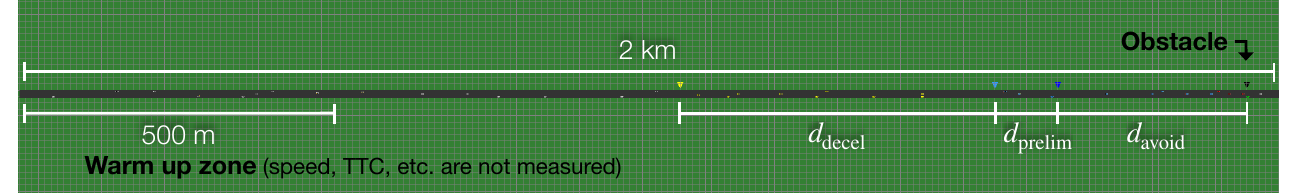
Figure 5. Traffic flow simulation in SUMO.